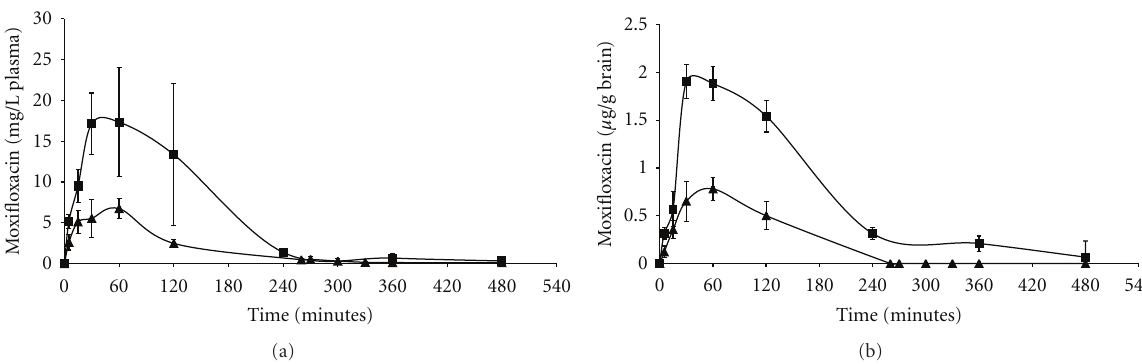
Figure 3: (a) Plasma concentration time course (mg/L) of moxifloxacin in mice (infected (cid:2) or not (cid:3) ) after a single i.v. administration of 50mg per kg of bodyweight (bolus injection) ( n = 6); (b) brain concentration time course ( µ g/g of brain) of moxifloxacin in mice (infected (cid:2) or not (cid:3) ) after a single i.v. administration of 50 mg per kg of body weight (bolus injection) ( n =